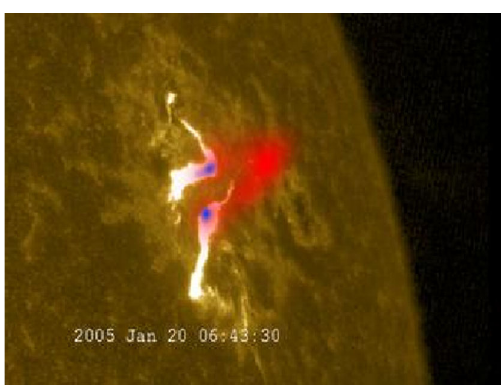
Fig. 9 Still from a movie: Left RHESSI flare observations of soft X-rays ( red 8–12 keV) and hard X-rays ( blue 20–50 keV) overlaid on an H α background. Note the high-energy